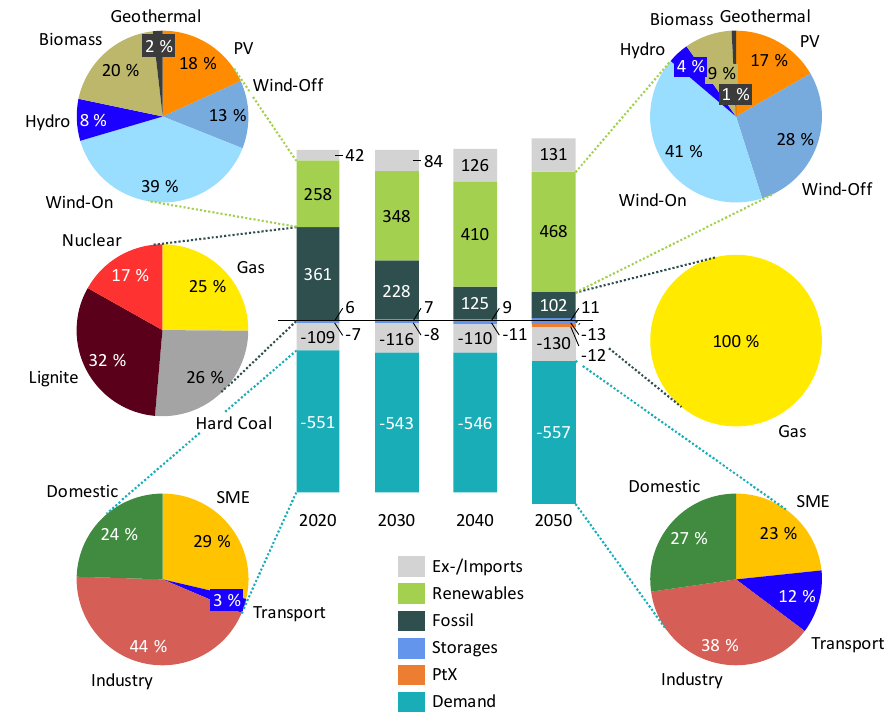
Figure 4. Resulting German energy balance for electricity in TWh.